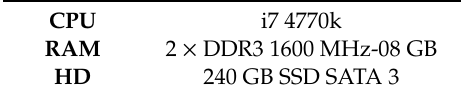
Table 3. Hardware configuration used in the